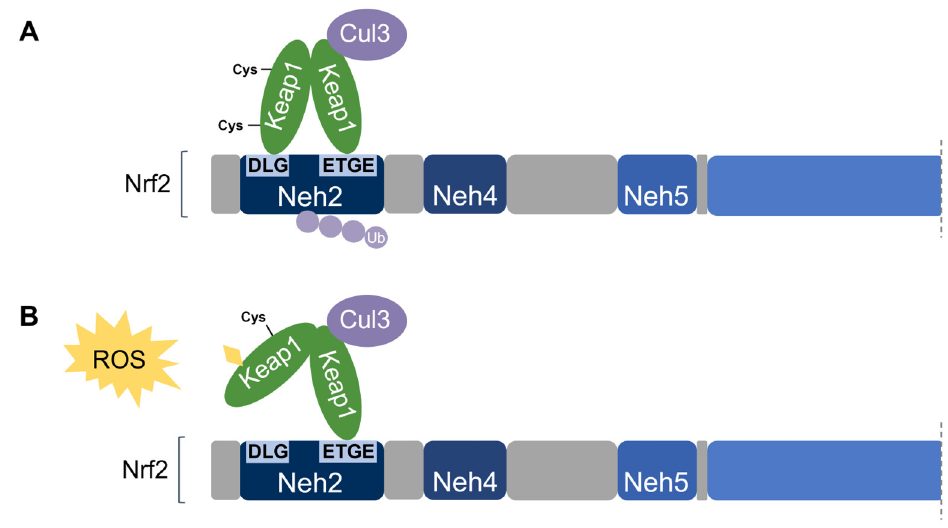
Figure 7. Two-site substrate recognition model for Keap1-dependent Nrf2 regulation. ( A ) A Keap1 homodimer binds to the Neh2 domain of Nrf2 at the DLG and ETGE motifs, allowing for the ubiquitination of Nrf2 by Cul3. ( B ) Stress-sensing cysteine residue(s) in Keap1 are modified by oxidative stress (ROS) causing a conformational change in Keap1 that impairs Nrf2-binding. Nrf2 is stabilized and no ubiquitination occurs. Table 3. Examples of cytoprotective genes regulated by